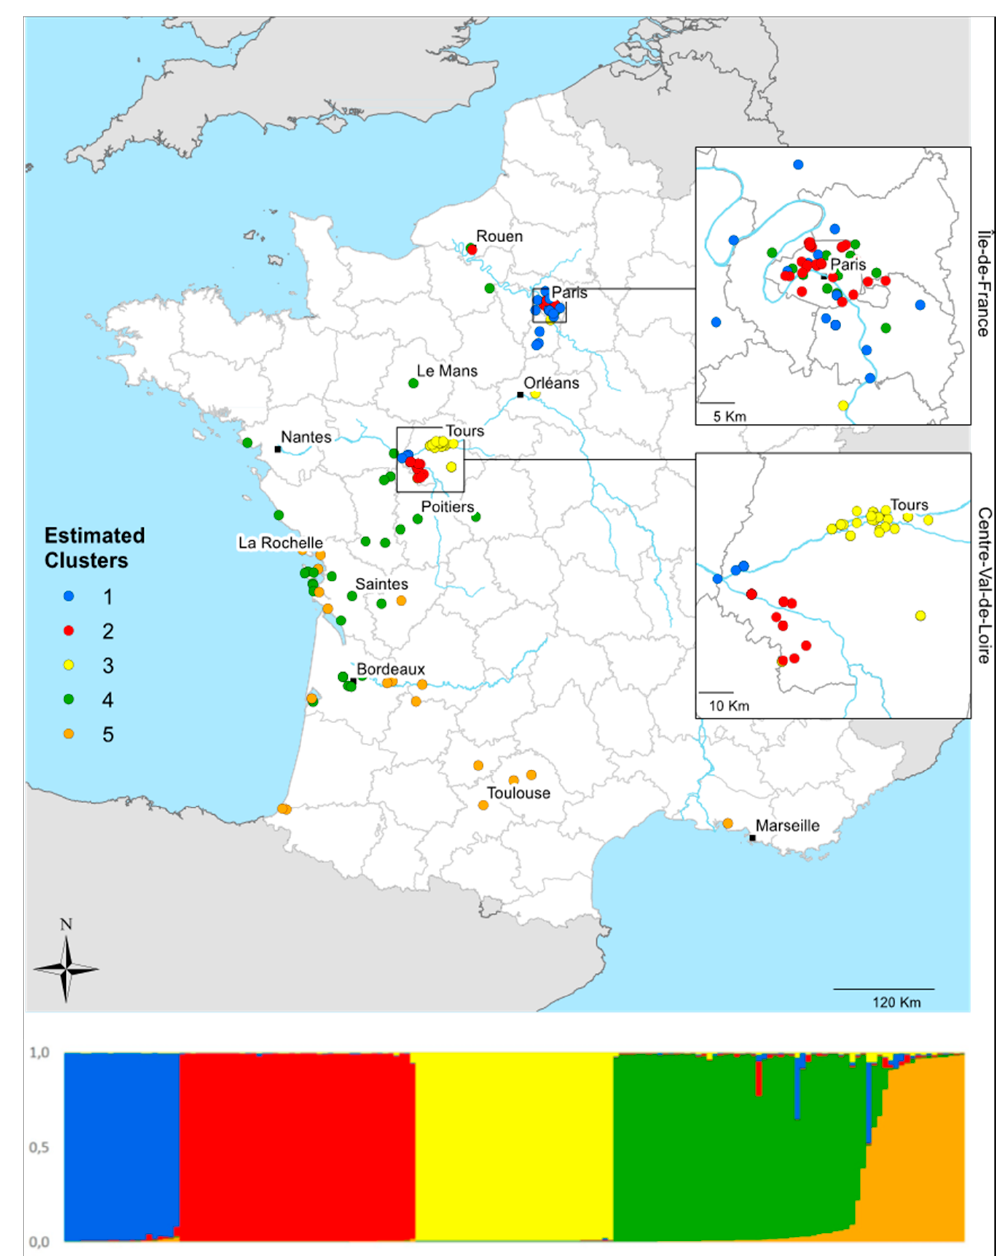
Figure 3. Map of Reticulitermes flavipes sampling locations in France. The map was created using ArcMap (ArcGIS v. 10.3.1). At the bottom of the figure, the assignment probability in the five clusters identified by STRUCTURE based on eight microsatellite loci is represented for each of 164 individuals: S1 (blue; n = 21), S2 (red; n = 43), S3 (yellow; n = 36), S4 (green; n = 46), and S5 (orange; n = 18).